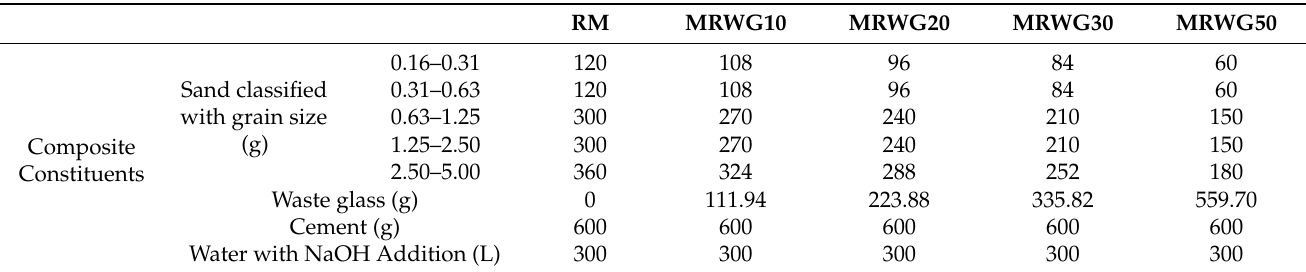
Table 4. Formulation of each mortar-based composite for ASR